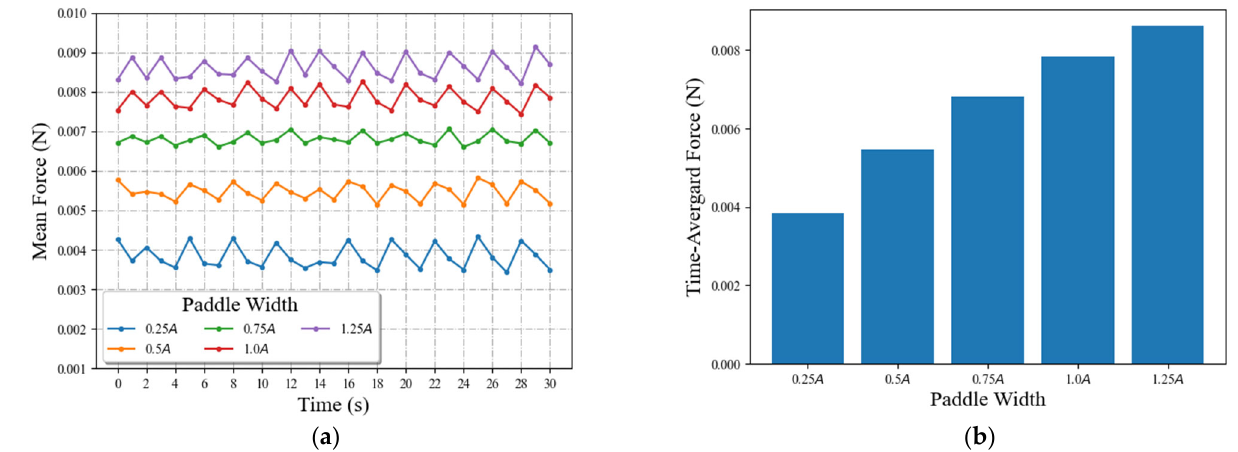
Figure 18. Force acting on particle in various paddle widths: ( a ) mean force and ( b ) time ‐ averaged force.